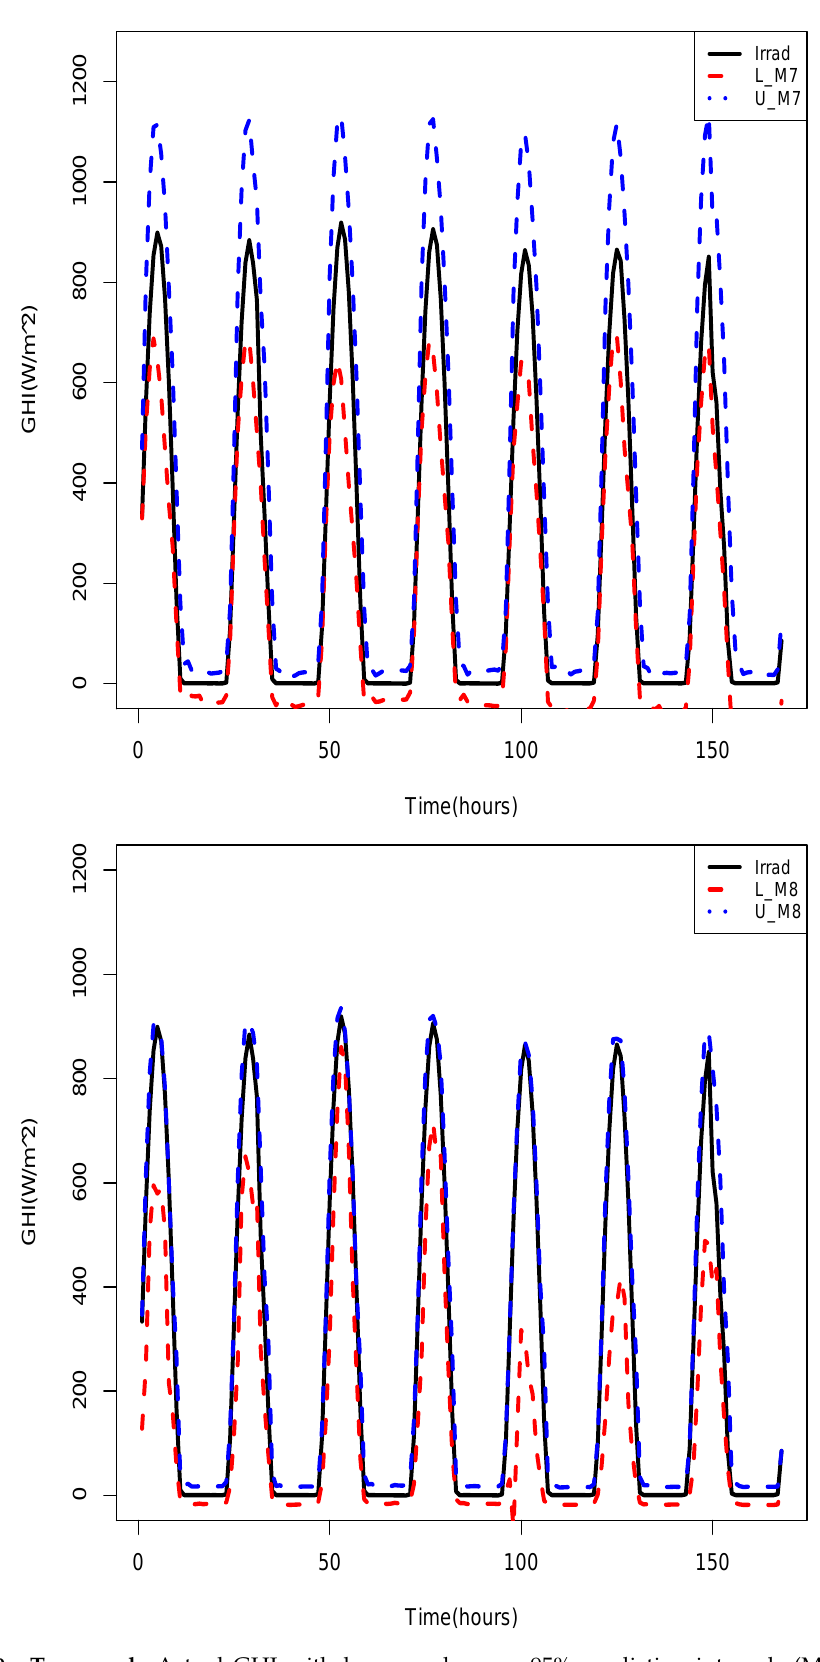
Figure 9. Top panel: Actual GHI with lower and upper 95% prediction intervals (M7 model). Bottom panel : Actual GHI with lower and upper 95% prediction intervals (M8